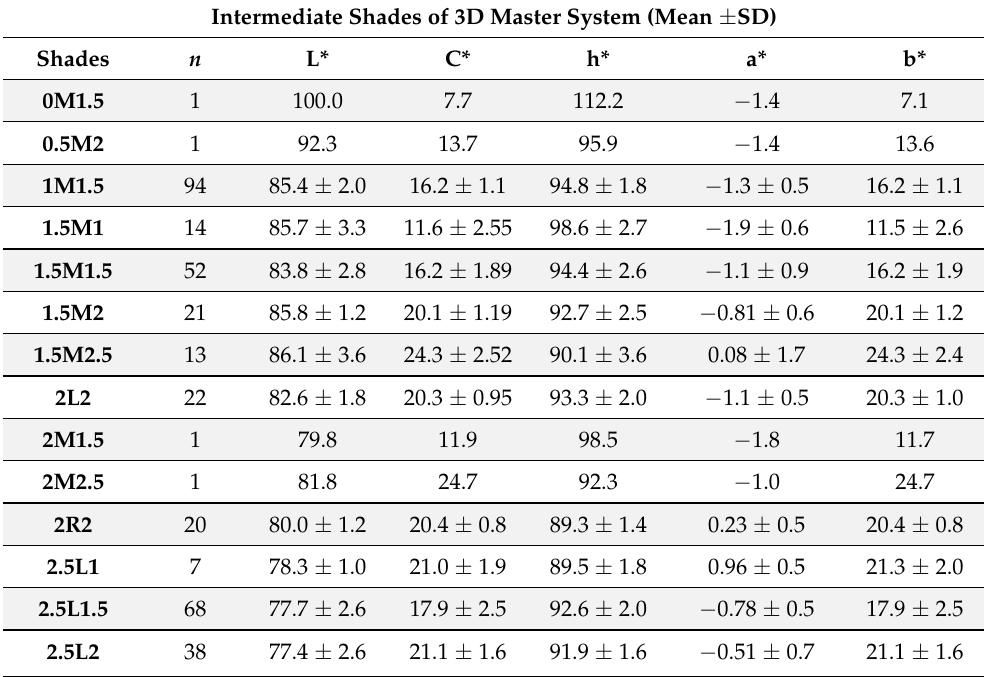
Table 1. Colour coordinates of the 49 “Intermediate shades” registered in the 3D Master System.